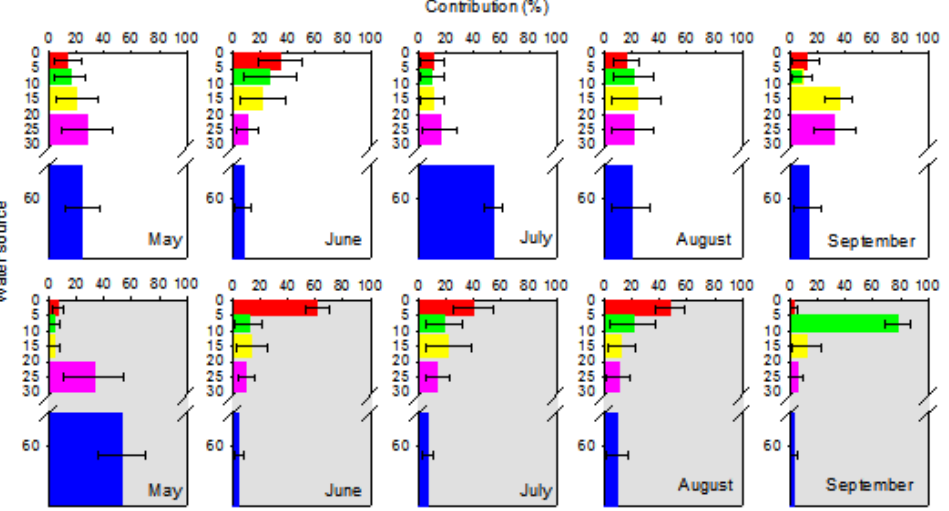
Figure 7. Contribution of soil water and groundwater to plant water uptake. Water uptake of Bromus inermis (white area) and Medicago sativa (gray area) from 0–5 cm, 5–10 cm, 10–20 cm, and 20–30 cm soil layers (above breaks) and ground water (below breaks) in different months. Bars indicate standard deviation.